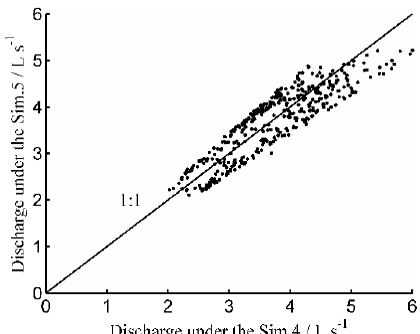
Figure 7. Optimal discharges were compared for Sim.4 and Sim.5. Notes: Sim.4: Inverted field mean infiltration parameters and Manning’s roughness of each furrow; Sim.5: Field mean infiltration parameters by PTF of each furrow and Manning’s roughness cumulative frequency as 50%.